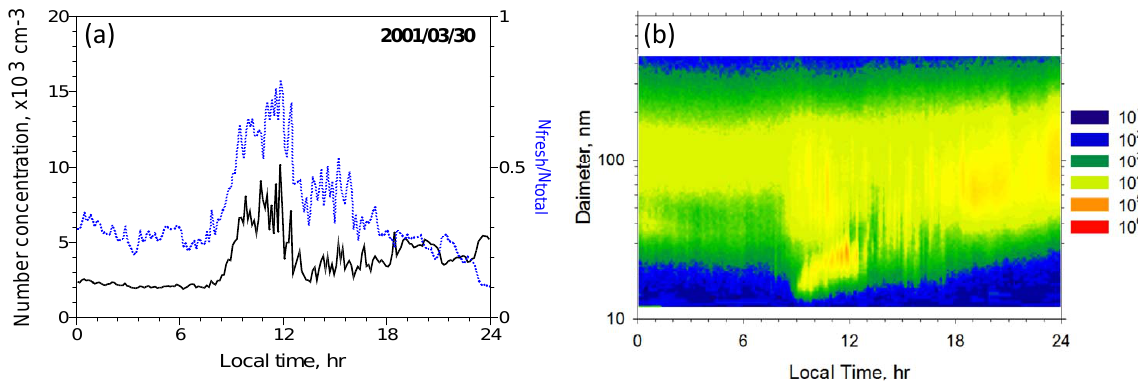
Fig. 1. An aerosol nucleation spikes event observed at a coastal site over Northern Taiwan on 30 March 2001. (a) Evolution of total aerosol number concentration (solid curve, left axis) and fraction of fresh particles (blue dotted curve, right axis); Fresh particles are defined as those with a diameter smaller than 30nm. (b) Evolution of aerosol particle size spectrum. The color bars show the particle number density ( dN / d log D) in cm − 3